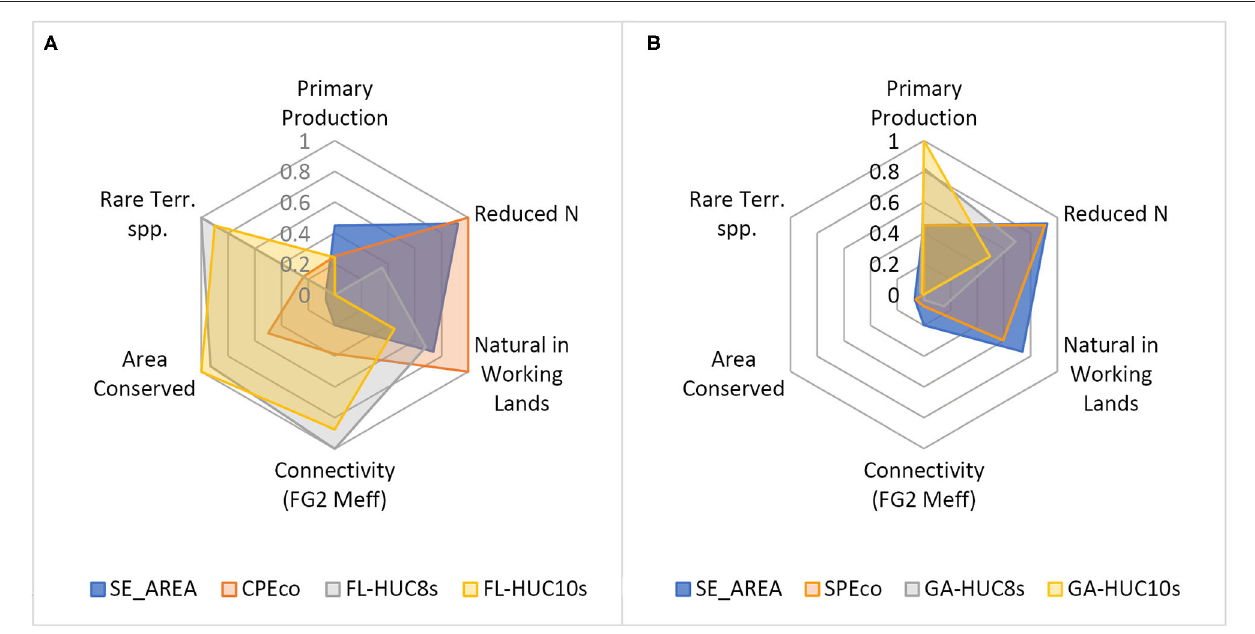
FIGURE 12 | Radar plots of six ecosystem service indicators for each of seven ecosystem service indicators: (clockwise from top) Primary production (mean NPP); Reduced N, the inverse of agricultural nitrogen runoff; Natural in Working Lands (ratio FG1:FG3); Connectivity (FG2 m eff , effective mesh size of the FG2 connecting elements, i.e. natural areas and low intensity working lands); Area Conserved (prop. MCL, proportion of lands protected for conservation); and Rare Terrestrial Species (TerrG1|G2, terrestrial G1|G2 imperiled species). (A) Florida study areas: SE megaregion, CPEco ecoregion, FL-HUC8s regional basins, and FL-HUC10s local watersheds. (B) Georgia study areas: SE megaregion, SPEco ecoregion, GA-HUC8s regional basins, and GA-HUC10s local